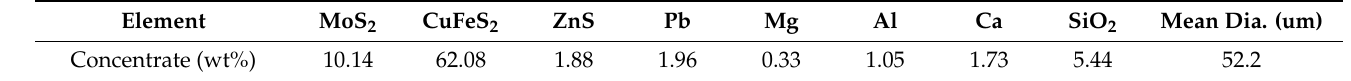
Table 1. The composition of ores and bulk